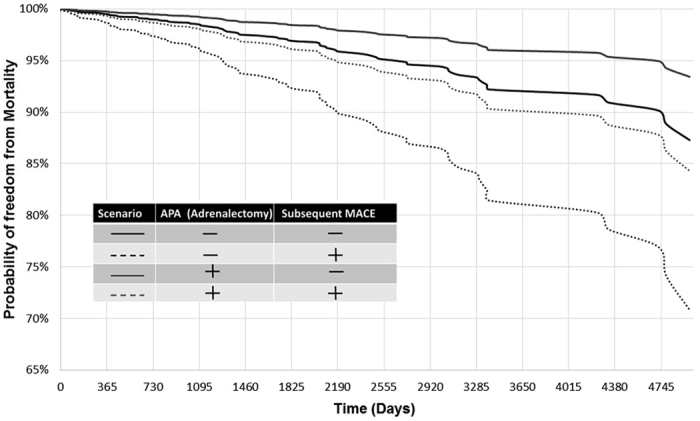
Future 10-year probability of mortality was lower among APA patients received adrenalectomy during follow up.The simulation curves were depicted based on different scenarios of morbid conditions with regard to MRA, and adrenalectomy stratified by subsequent MACE.